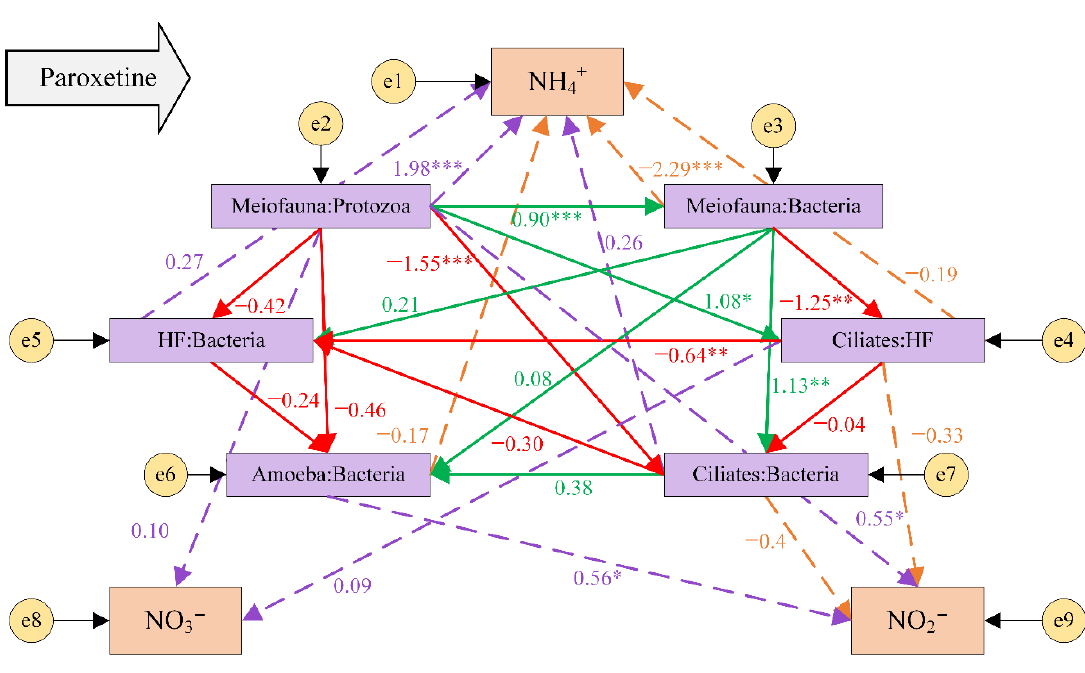
Figure 6. An analysis of the trophic transfer efficiency in response to the paroxetine addition using a structural equation model. HF are heterotrophic flagellates. Correlations are represented by different colors. Green and purple represent positive correlations; red and orange represent negative correlations; standardized path coefficients represented by numbers are close to the arrows. * indicates different degrees of significance (* p < 0.10; ** p < 0.05; *** p < 0.01).